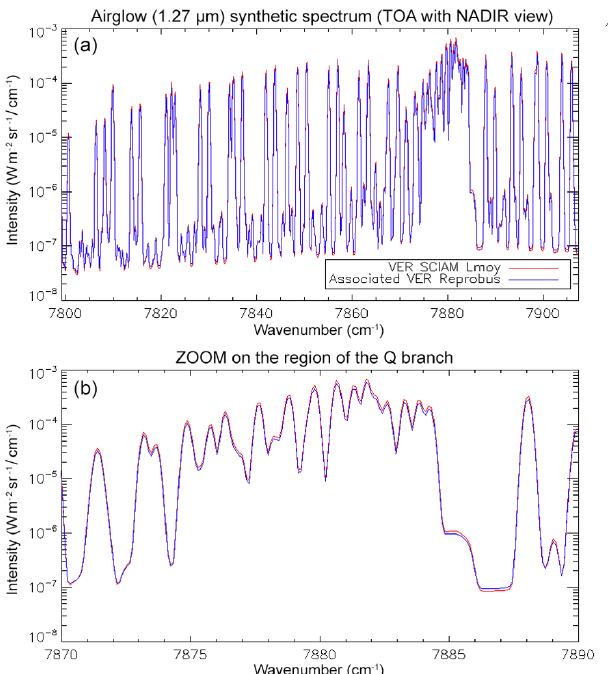
Figure D2. (a) Synthetic airglow spectra corresponding to the (red) SCIAMACHY VER profile of Fig. D1, (blue) associated REPROBUS VER profiles of Fig. D1. For the three tests, the red spectrum is put in the simulated data to invert. For test no. 1, it is also used as the Jacobian of the inverse model. For test no. 2, the blue spectrum is used as Jacobian of the inverse model (blue). The Jacobian spectra of test no. 3 are not represented here. (b) Zoom on the region of the Q